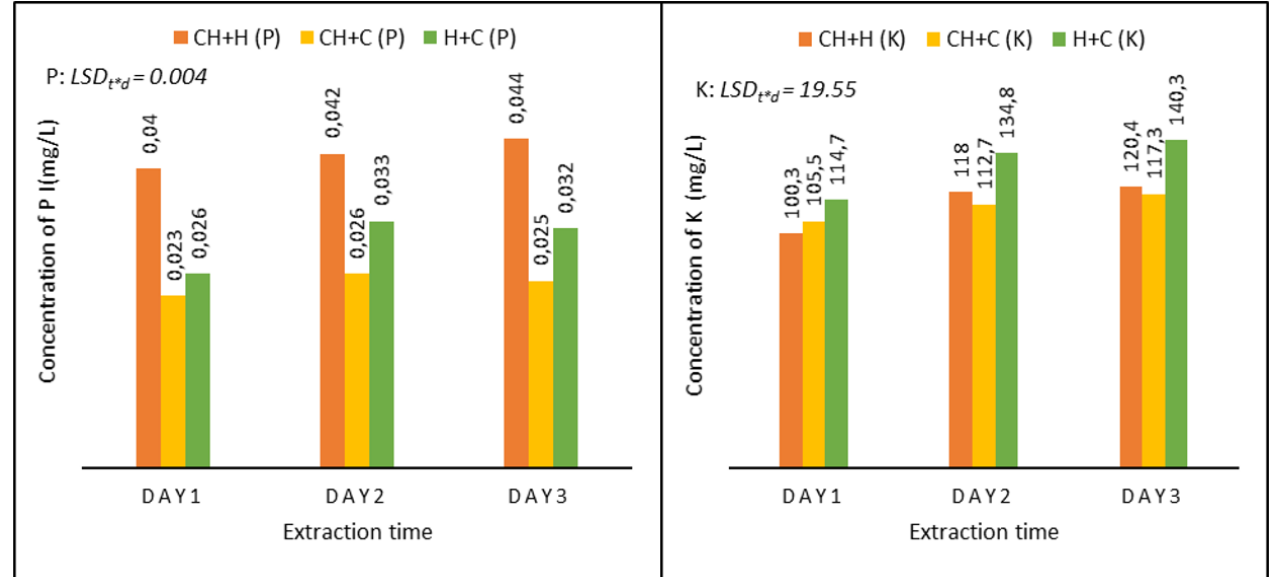
Figure 2. Determination of phosphorus and potassium in different vermicompost teas over 72-h extraction period.